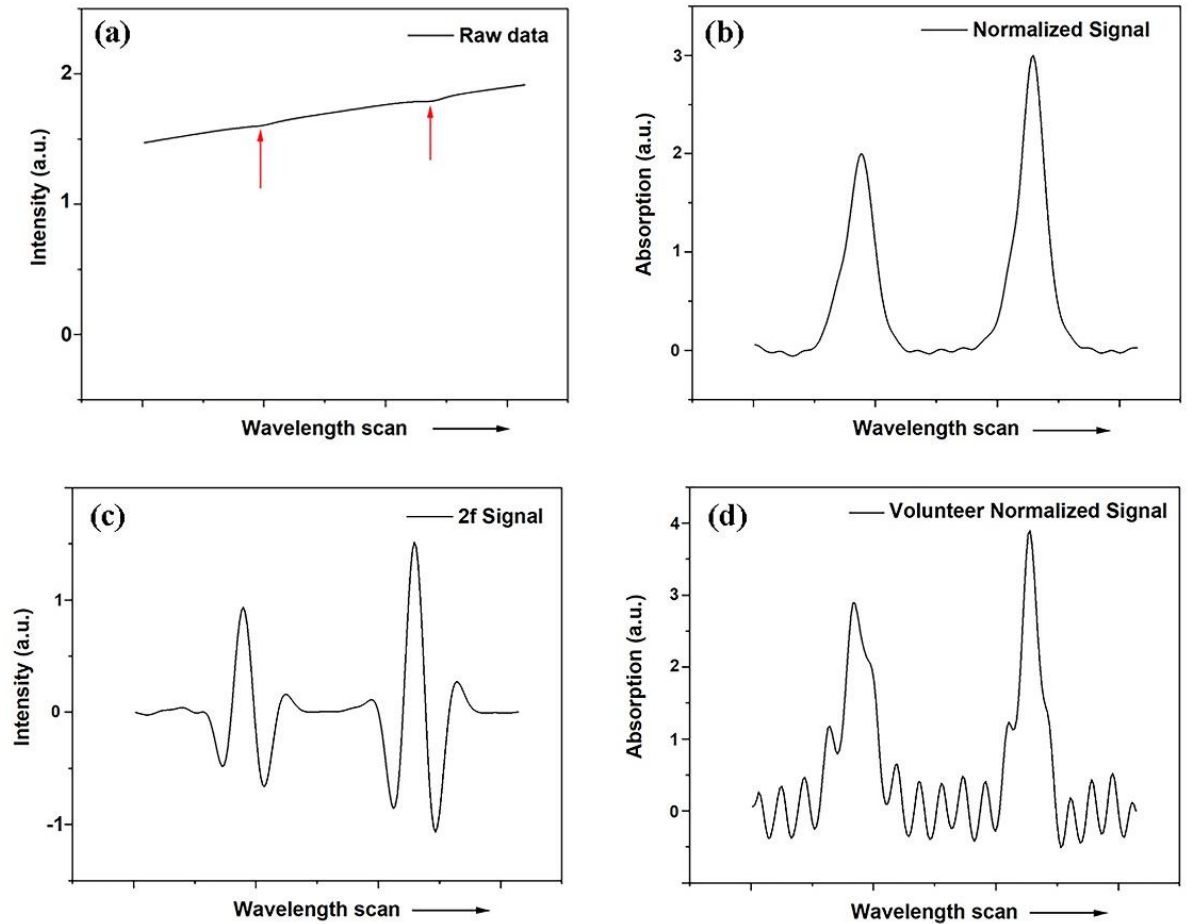
Figure 4. ( a ) Detector output when the laser frequency is ramped through two oxygen line positions. The sample is a 2 cm thick piece of polystyrene foam. ( b ) Isolated oxygen absorption signals derived from the data in ( a ). ( c ) The second derivative of the data shown in ( b ). ( d ) Typical recording of oxygen signals recorded through a human frontal sinus. The fitted fractional gas absorption is in our instrument expressed in the unit percent meter (%*m), since only the product of concentration and interrogated gas distance is determined.